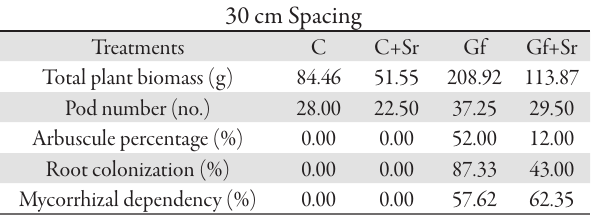
Tab. 6. Total biomass, pod number, arbuscule percentage,